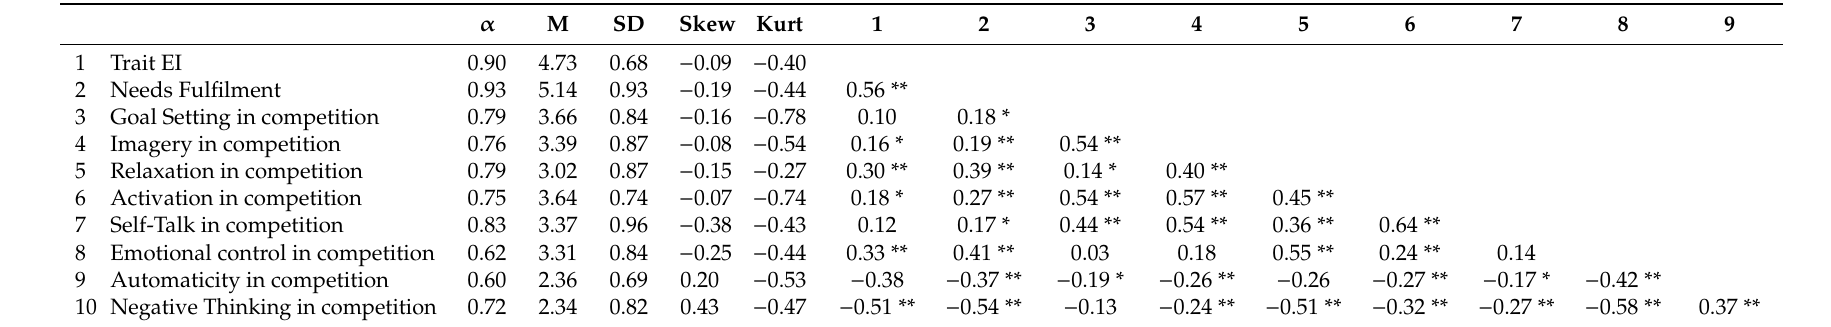
Table 2. Descriptive Analysis and Correlations in competition